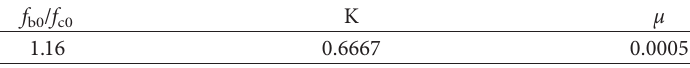
Table 2: Unified hardening model parameters.